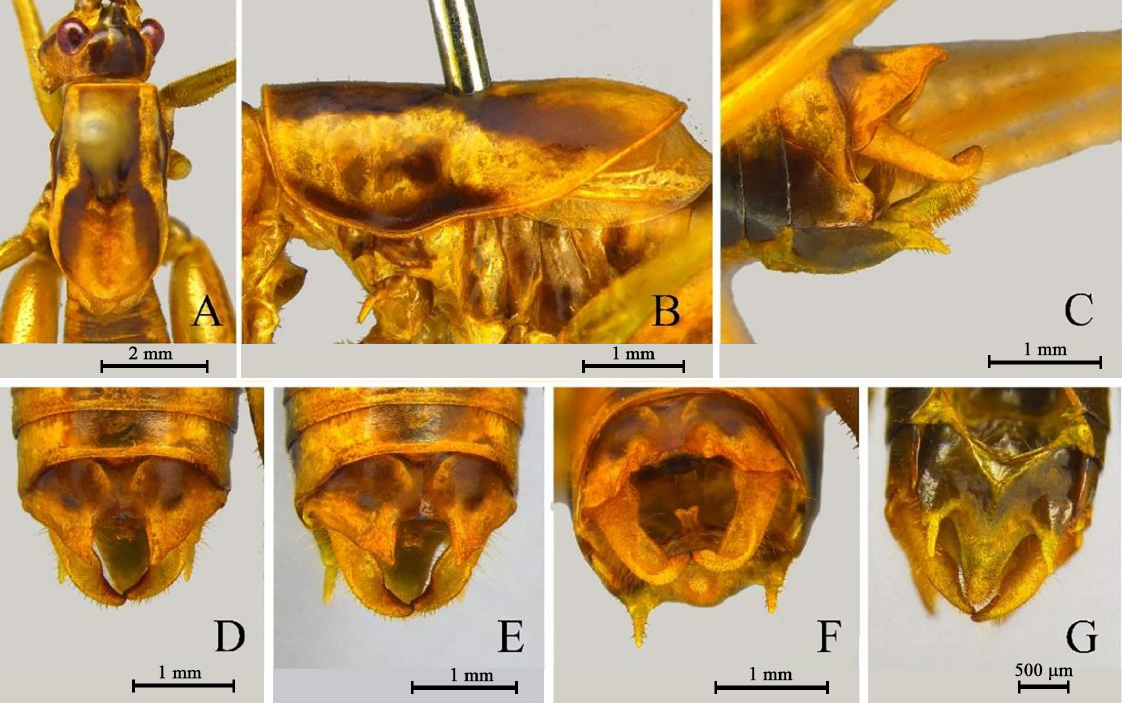
Fig. 2. Acosmetides dilobosa gen. et sp. nov., holotype, ♂ (HBU). – A–B . Pronotum. A . Dorsal view. B . Lateral view. – C–G . Apex of abdomen. C . Lateral view. D–E . Dorsal view. F . Apico-dorsal view. G . Ventral